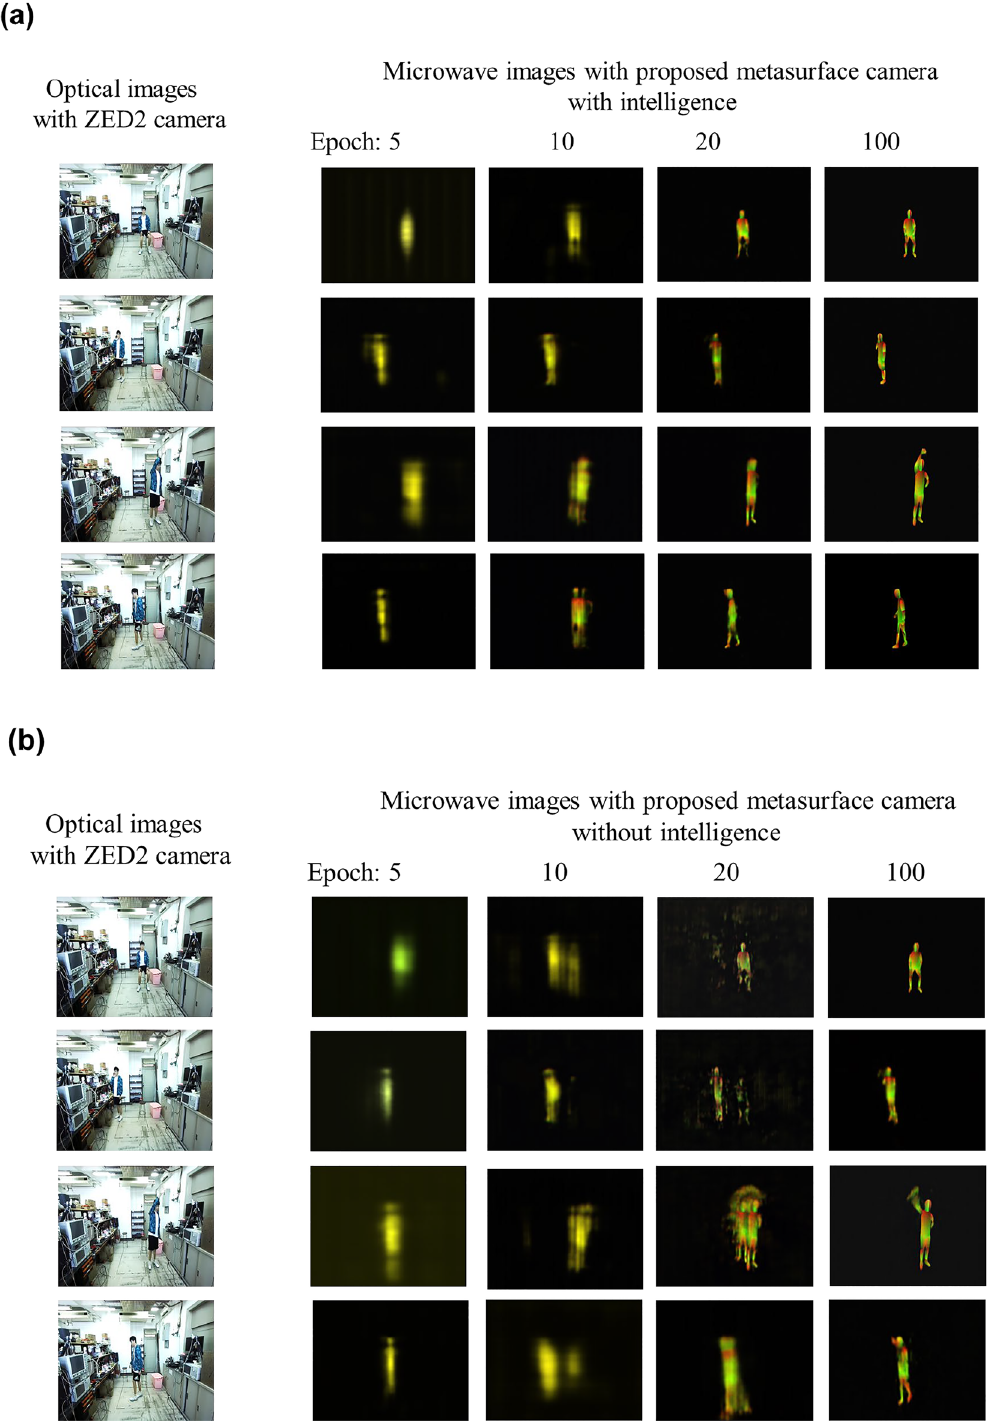
Figure 5: Performance evaluation of proposed EM metasurface camera for sensing human behaviors in indoor environment. (a)and(b)correspondtoselectedIUVimagesoftestpersonwithfourdifferentgestureswithvaryingtrainingepochs,wheretheintelligenceis involved and not, respectively. (c) Comparison of convergence behaviors of MSEs over 1000 1.2 s-length microwave videos as function of trainingepochswhentheintelligenceisinvolved(blueline)ornot(orangeline).(d)FiguresinLeftandRightareforthenormalizedhistograms of PSNRS over 1000 1.2 s-length microwave videos recorded using our EM metasurface camera with or without